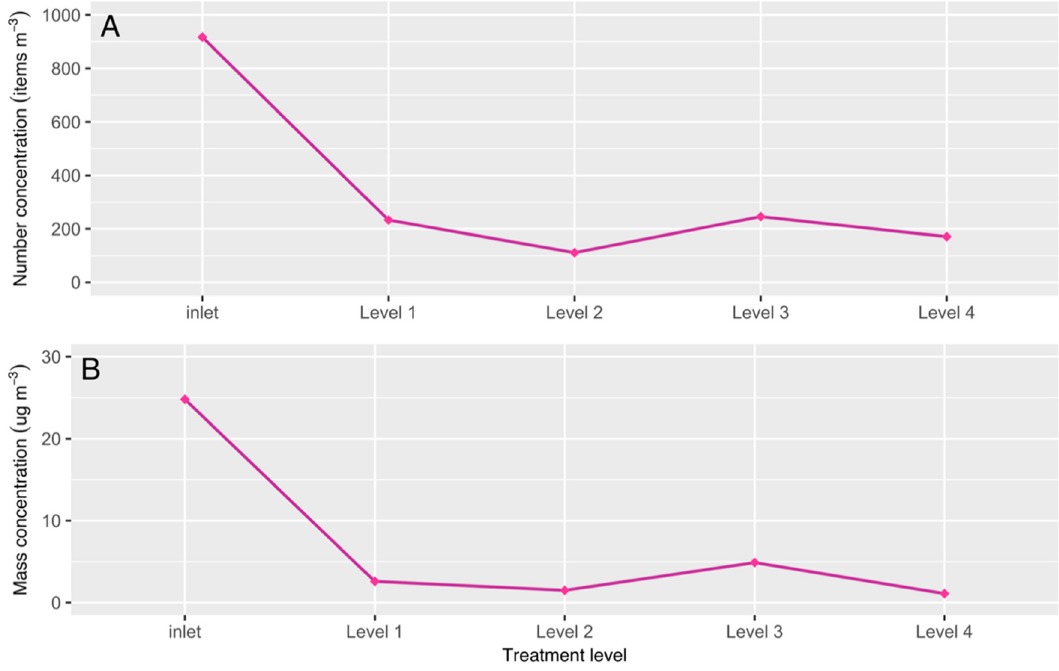
Figure 2. Microplastic (MP) number concentration ( A ) and mass concentration ( B ) of inlet and four filtration levels.